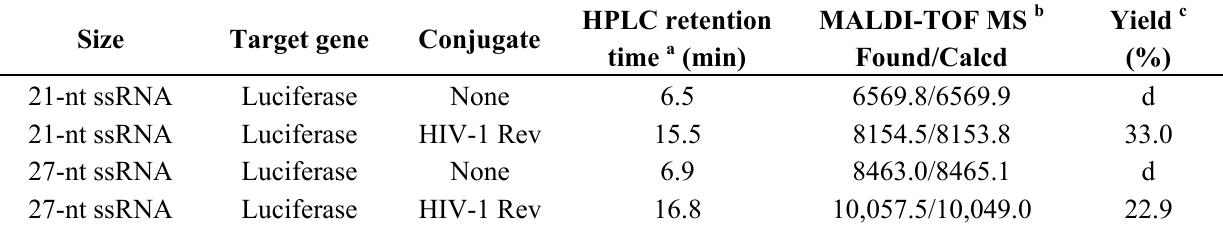
Table 1. Characterizations of ssRNAs conjugated with